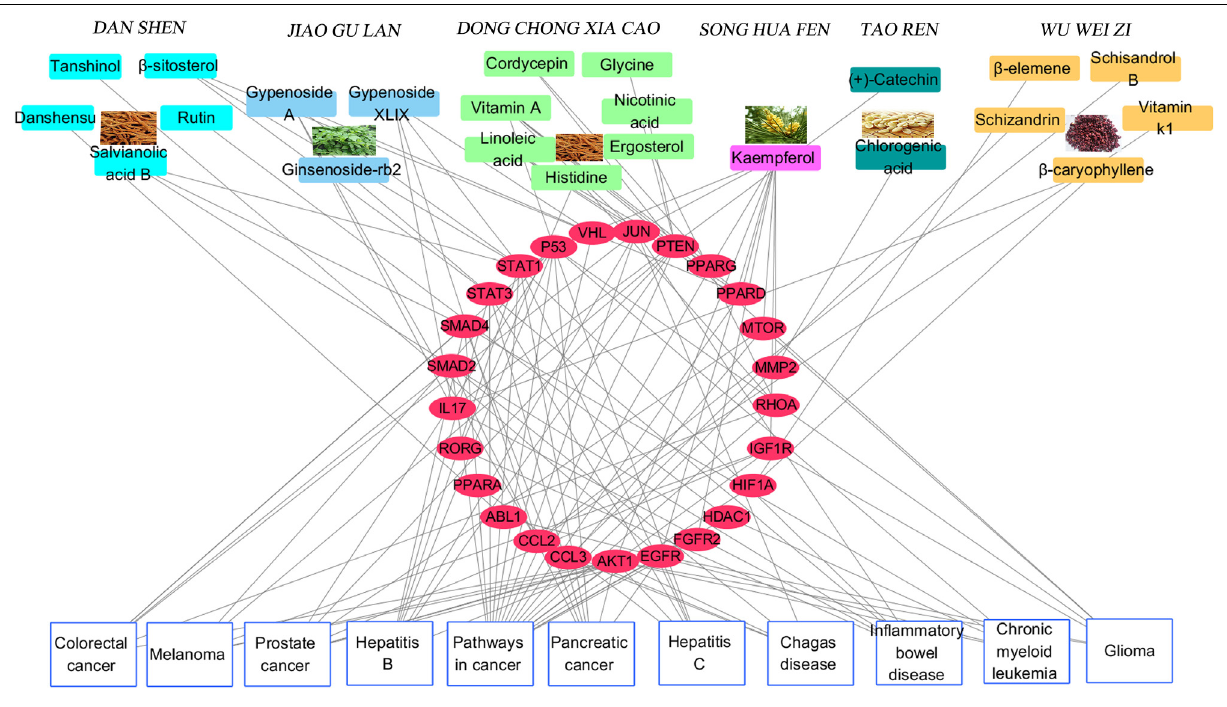
with existing research results. Target proteins related to